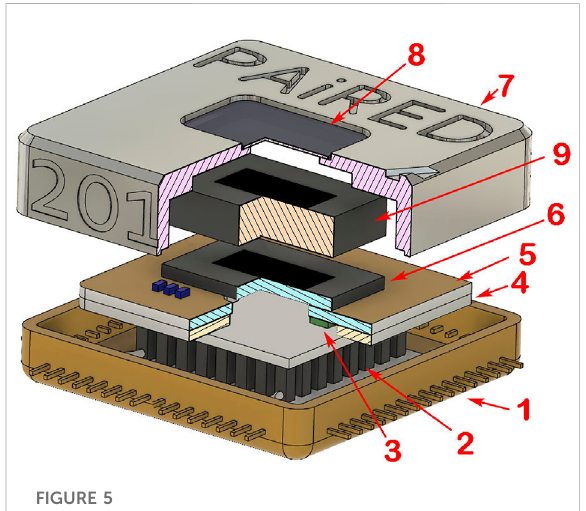
FIGURE 5 Viewofthedetectionmoduleshowingthemaincomponents of the assembly.